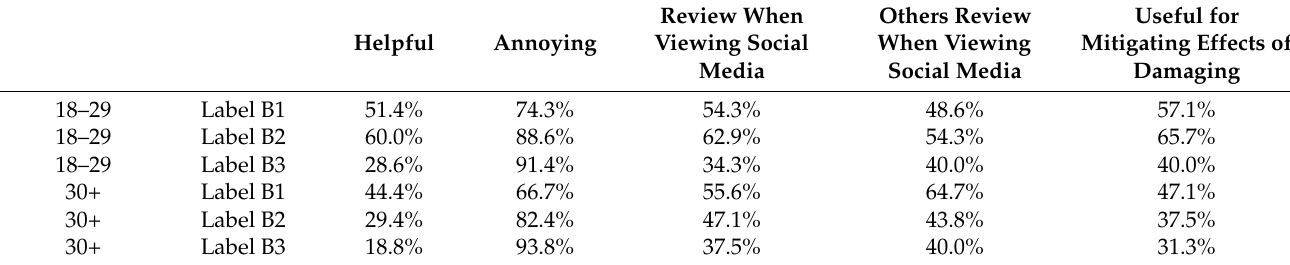
Table 11. Results of survey 3 by label and by age group.